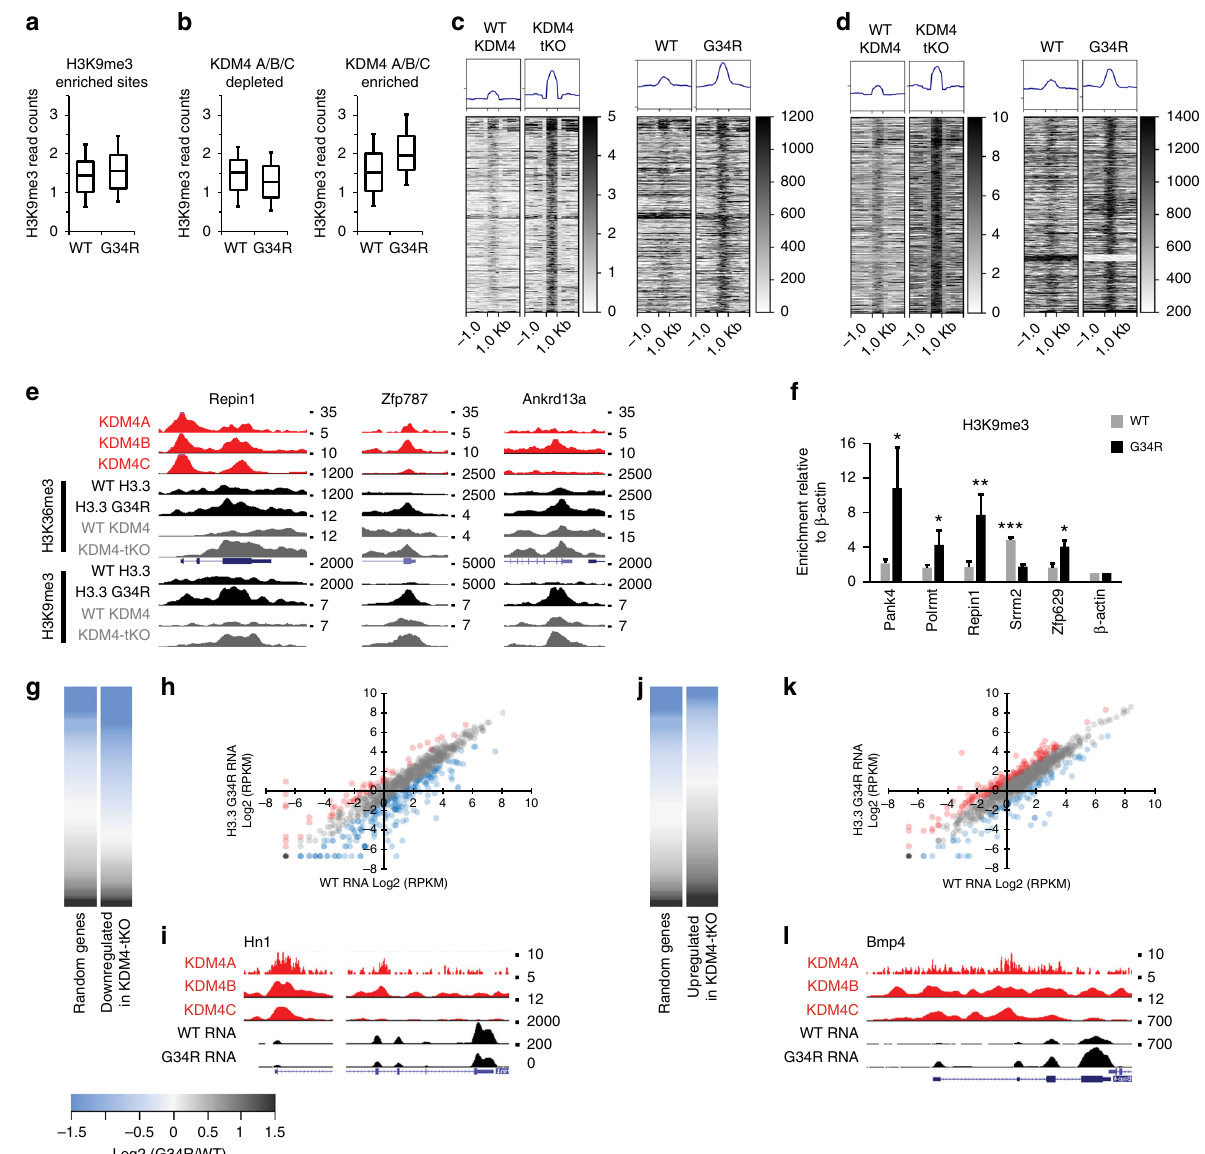
Fig. 3 H3.3 G34R triggers gains in H3K9me3 and genocopies KDM4 A/B/C triple-knockout. a Normalised H3K9me3 ChIP-seq reads across all H3K9me3- enriched genes in WT and G34R cells. b Normalised H3K9me3 read counts at KDM4 A/B/C depleted ( n = 2953) and enriched ( n = 4761) genomic regions. c , d Heatmaps of c H3K9me3 and d H3K36me3 ChIP-seq reads at sites which gain (>1.5-fold) H3K9me3 ( n = 927) or H3K36me3 ( n = 439) in KDM4-tKO mutants (±1 kb) with pro fi les of corresponding regions in WT and G34R cells. e Representative screenshots of genes ( Repin1, Zfp787, Ankrd13a ) enriched for KDM4 which gain H3K9me3 and H3K36me3 in both KDM4-tKO cells and G34R mutants. H3K9me3 and H3K36me3 ChIP-seq in KDM4- tKO 36 were obtained from GEO (accession number GSE64252). f H3K9me3 ChIP-qPCR in WT and G34R cells. Results are normalised for input and bars represent mean enrichment of three independent experiments, calculated relative to a negative control ( β -actin promoter). Error bars represent standard deviation of three independent experiments ( n = 3). P -values calculated using Student ’ s T -test (* P < 0.05, ** P < 0.01, *** P < 0.0001). g Heatmap of log 2 (G34R/WT RPKM) of genes which were downregulated in KDM4-tKO ( n = 933) compared against a random selection ( n = 933) of genes. h log 2 (RPKM) of WT vs G34R RNA-seq of genes downregulated in KDM4-tKO ( n = 933). i Representative screenshot of a gene which is downregulated in KDM4-tKO. j Heatmap of log 2 (G34R/WT RPKM) of genes which were upregulated in KDM4-tKO ( n = 1099) compared against a random selection ( n = 1099) of genes. k log 2 (RPKM) of WT vs G34R RNA-seq of genes upregulated in KDM4-tKO ( n = 1099). l Representative screenshot of a gene which is upregulated in KDM4-tKO. Red and blue circles indicate genes which are >2-fold up or downregulated in G34R relative to WT. Boxes represent 25th, median and 75th percentile; whiskers represent 10th and 90th